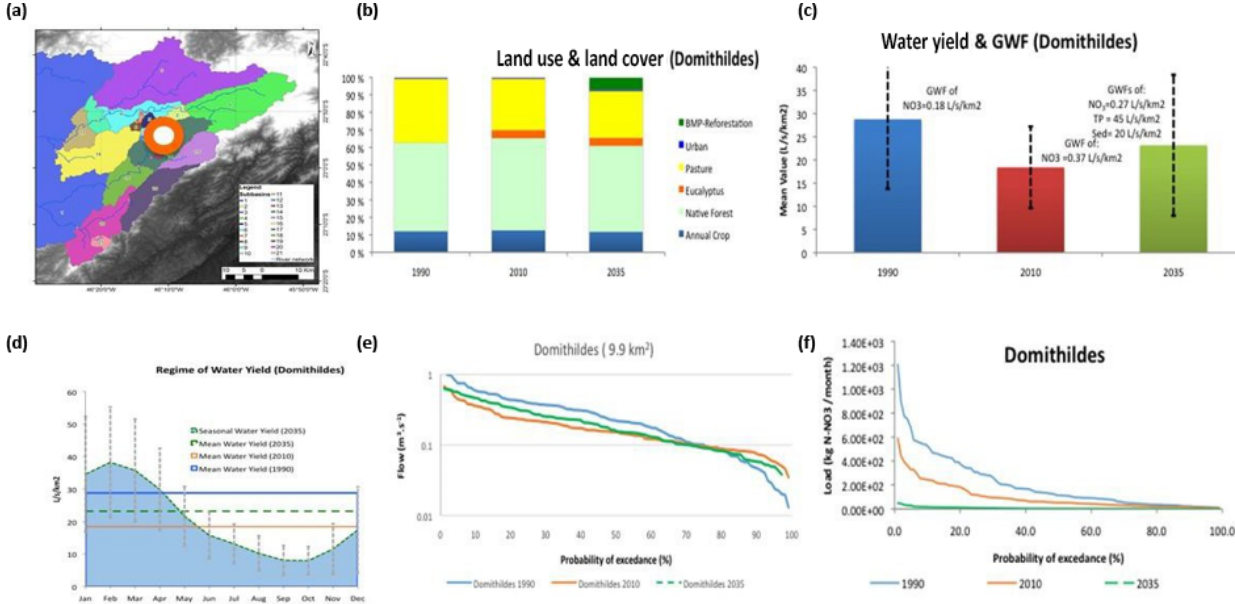
Figure 14. Synthesis chart of case study the Domithildes catchment (drainage area = 9 . 9km 2 ). (a) Localization at the drainage areas of the Cantareira system; (b) LULC conditions for scenarios S1 (1990), S2 (2010) and S2 + EbA (2035); (c) comparison of water yields simulated for conditions of S1, S2 and S2 + EbA; (d) water yield scenarios compared with intra-annual regime of S2 + EbA scenario; (e) comparison of duration curves of flows for S1, S2 and S2 + EbA conditions; (f) duration curves of N-NO3 loads for S1, S2 and S2 +